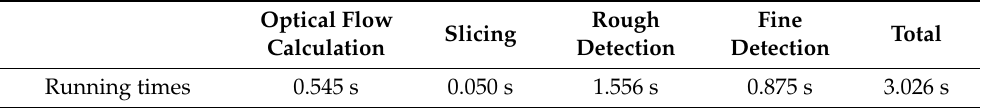
Table 4. The average running times for one calculation process of our algorithm.